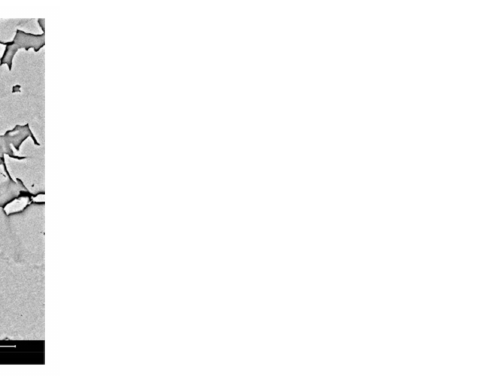
Figure 17. X-ray diffraction pattern for the FeTa 0.5 Nb 0.5 TiZr 0.5 alloy.